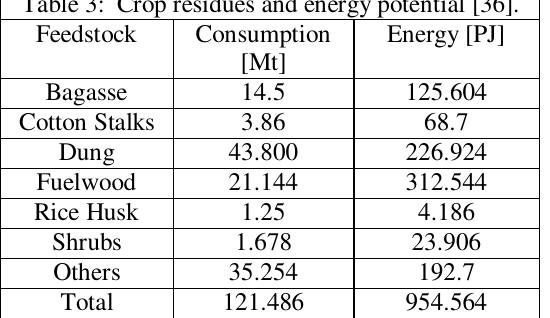
Table 3: Crop residues and energy potential [36].